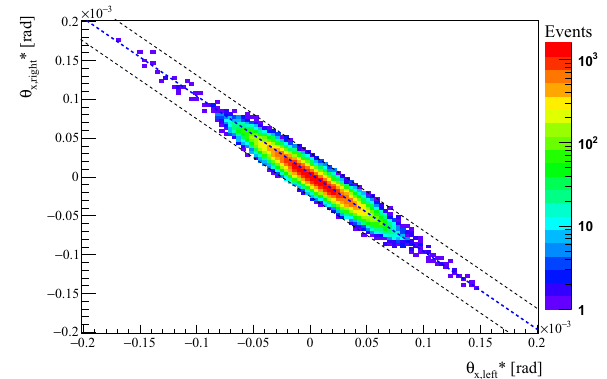
Fig. 1 Analysis cut in the horizontal scattering angle θ ∗ x . The blue and black dashed lines represent the mean and the 4 σ cuts, respectively